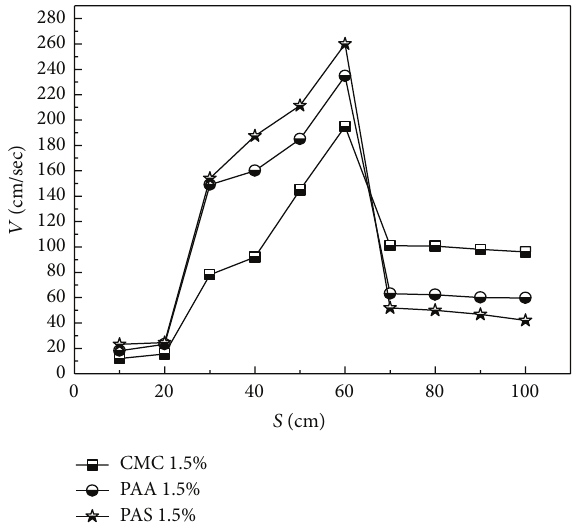
Figure 10: Fractional coverage 𝑚 as a function of capillary number Ca when sudden contraction tube angle is 𝜃 = 45 ∘ , 𝑄 = 600 mL/min and 𝐻 = 𝑑 1